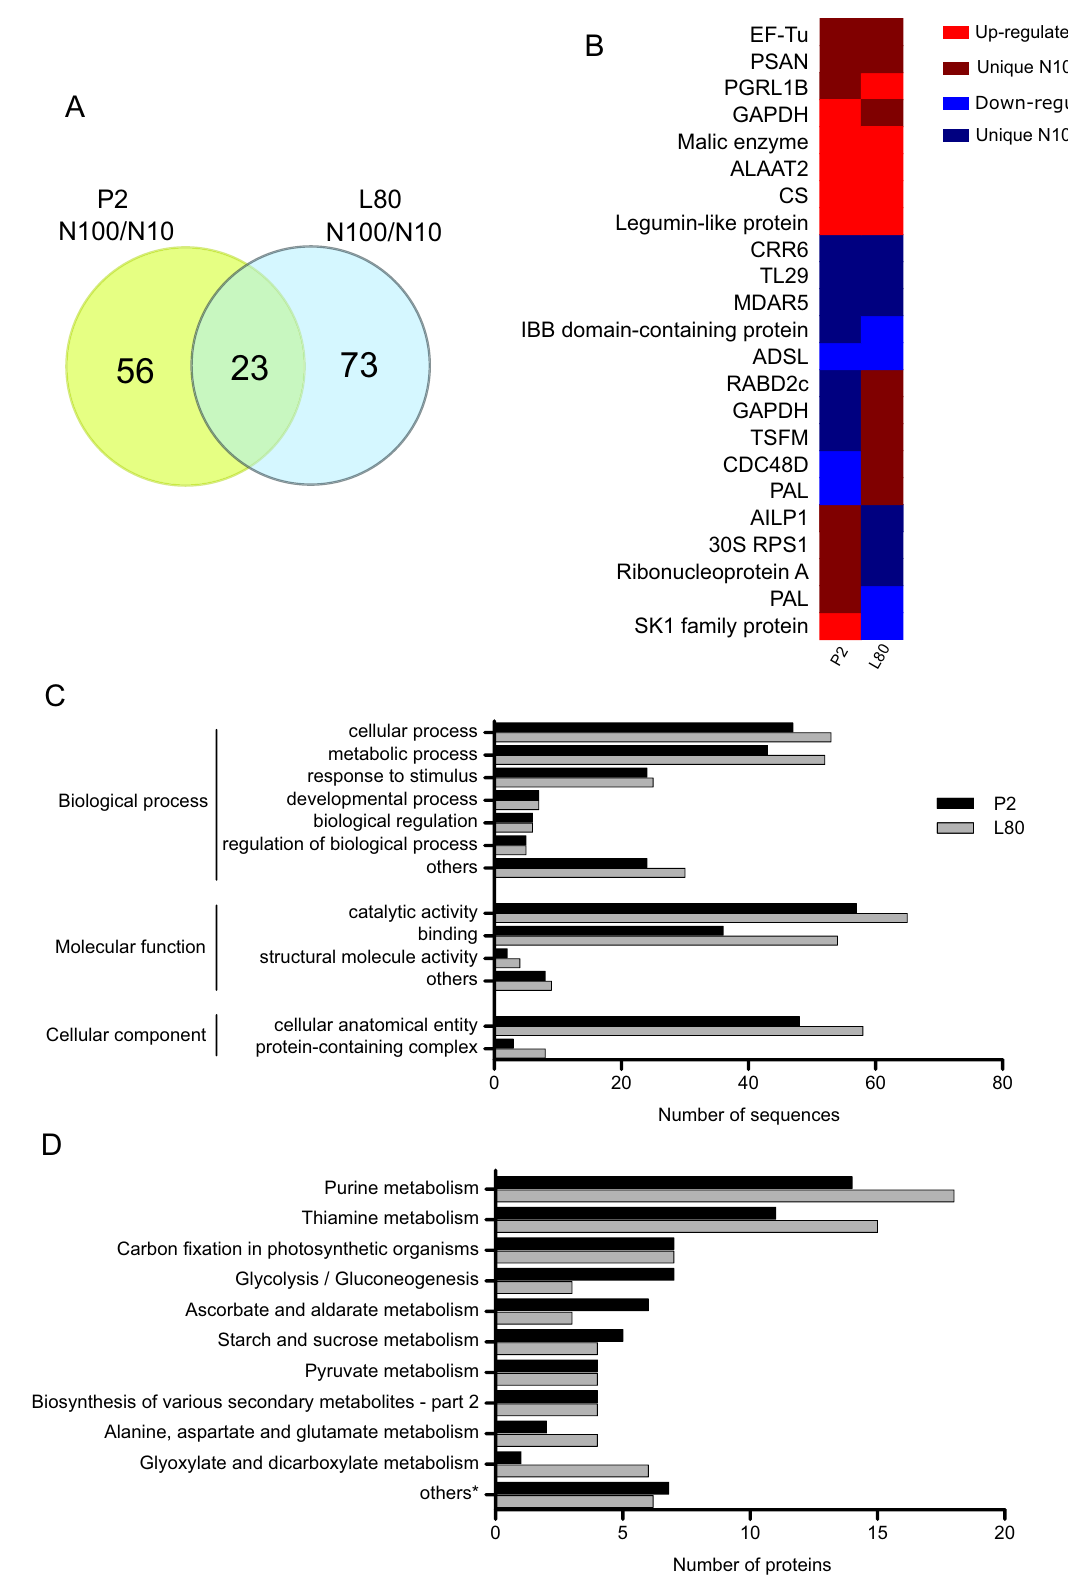
Figure 3. Comparative proteomic analysis of P2 and L80 under high (N100) and low (N10) N-supplies. ( A ) Venn diagram of differentially accumulated proteins (DAPs), ( B ) DAPs observed in both inbred lines, ( C ) GO enrichment analysis of GO level 2, and ( D ) KEGG enrichment analysis. *The number of DAPs were divided by ten. Heatmap was generated in R version 3.6.2 (https:// www.r- proje ct.